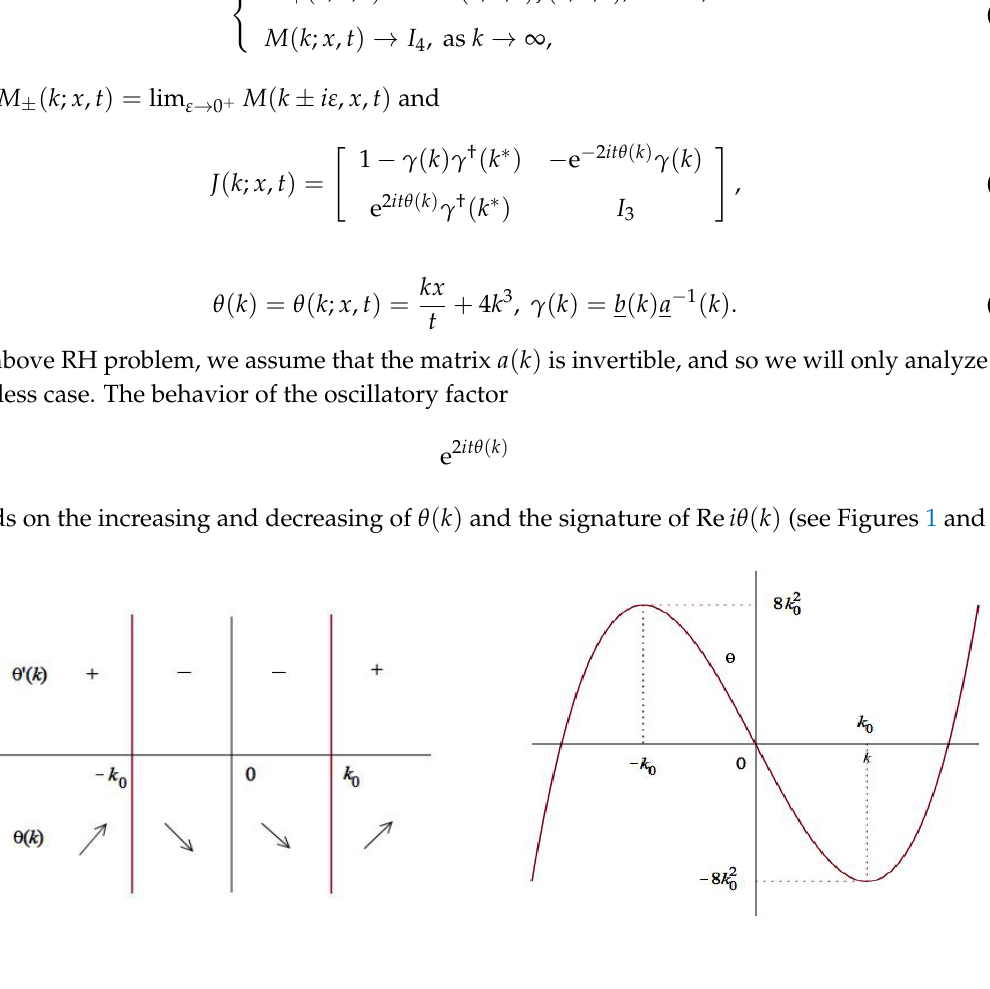
Figure 1. Increasing and decreasing of θ